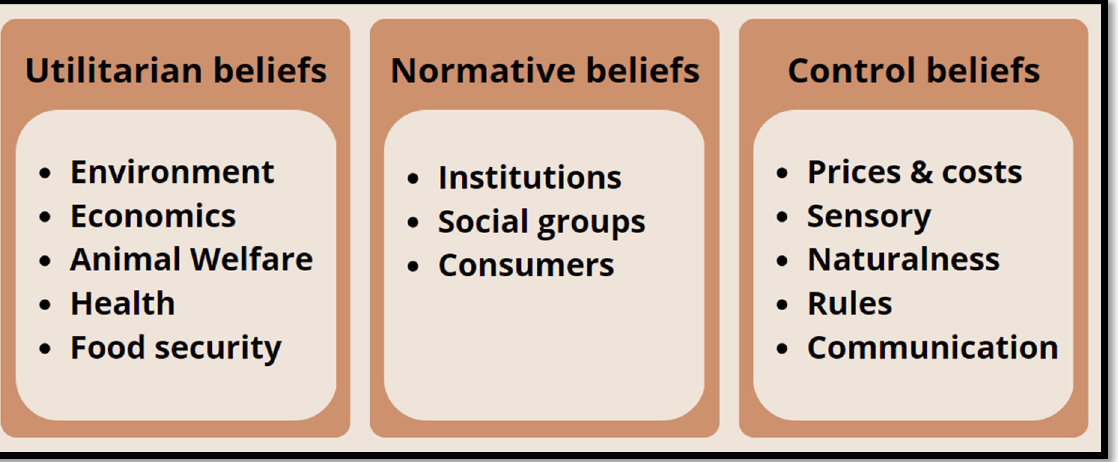
Figure 1. Main categories of beliefs.